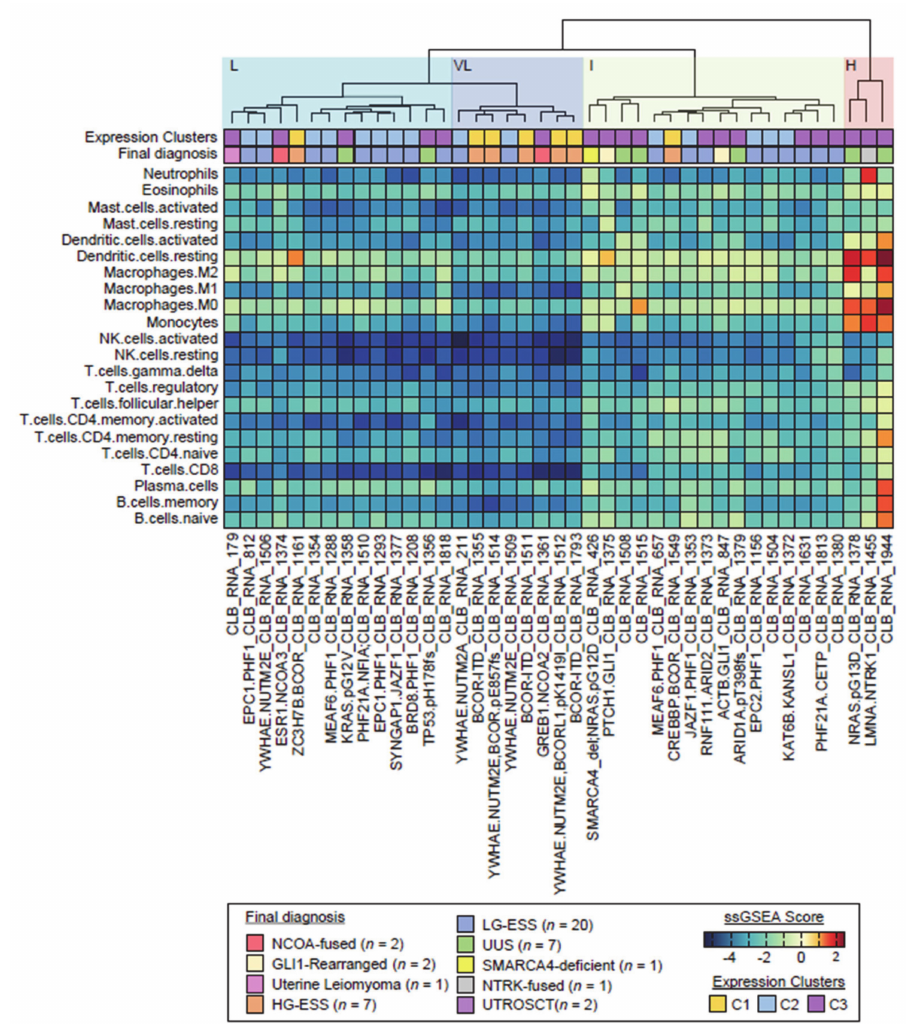
Figure 3. Hierarchical unsupervised clustering of the investigation cohort ( n = 43) upon immune infiltrate population profiles. Cluster analyses generated one group with high (H) immune infiltrate and one group with low immune infiltrate subdivided in 3 slightly di ff erent subtypes: very low (VL), low (L) and intermediate (I). Clusters from Figure 1 and final diagnosis are also